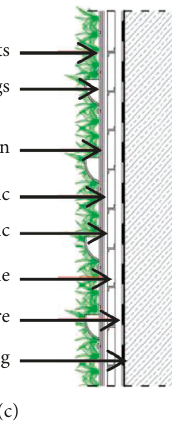
Figure 5: (a) Example scheme of the “green façade.” (b) Example scheme of the “living wall.” (c) Example scheme of the “garden Table 2: Functions of vegetation in green walls.